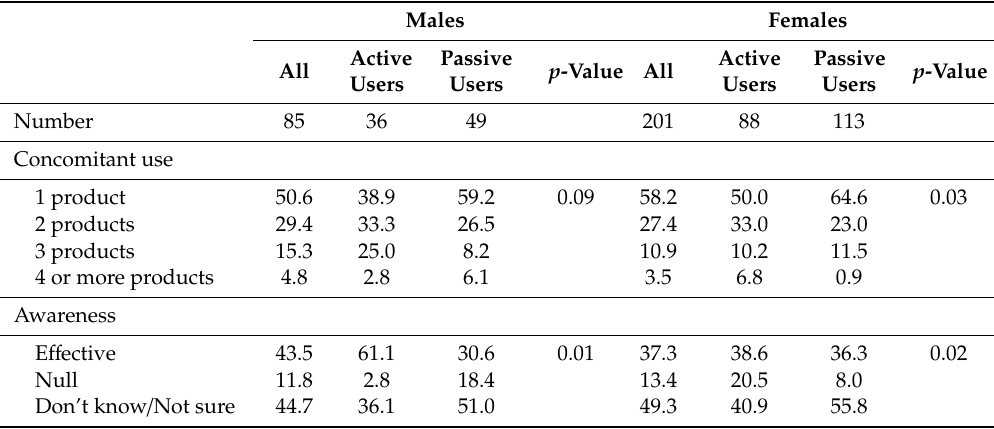
Table 6. A comparison of concomitant use and awareness of the e ff ectiveness of dietary supplements in active and passive users (% of